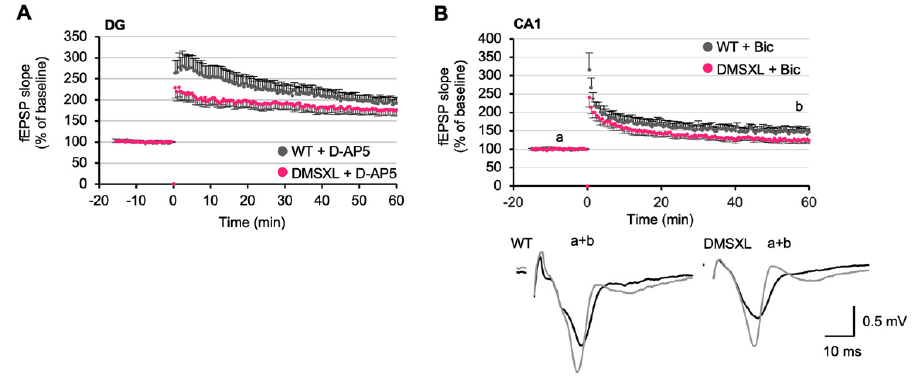
Figure 6. Contribution of NMDA and GABA receptors to altered LTP in DMSXL mice. ( A ) LTP in DG in the presence of the NMDA antagonist D-AP5 (0.5 µM) (DMSXL, n = 8 mice, n = 18 slices; WT, n = 7 mice, n = 16 slices). APV was added to the superfusion bath 20 min before high-frequency stimulation and during the entire recording. D-AP5 did not restore the lower strength of LTP in DMSXL mice. ( B ) LTP in the CA1 area in the presence of the GABA A antagonist Bic (4 µM) in DMSXL ( n = 4 mice, n = 9 slices) and WT ( n = 3 mice, n = 7 slices) mice. Bic was added to the perfusion bath 20 min before high-frequency stimulation and during all the recording. Bic did not restore the lower strength of LTP in DMSXL mice. Representative superimposed sample traces of evoked AMPAR-mediated fEPSPs before (a) and after (b) completion of LTP in a slice from WT and a slice from DMSXL mice.